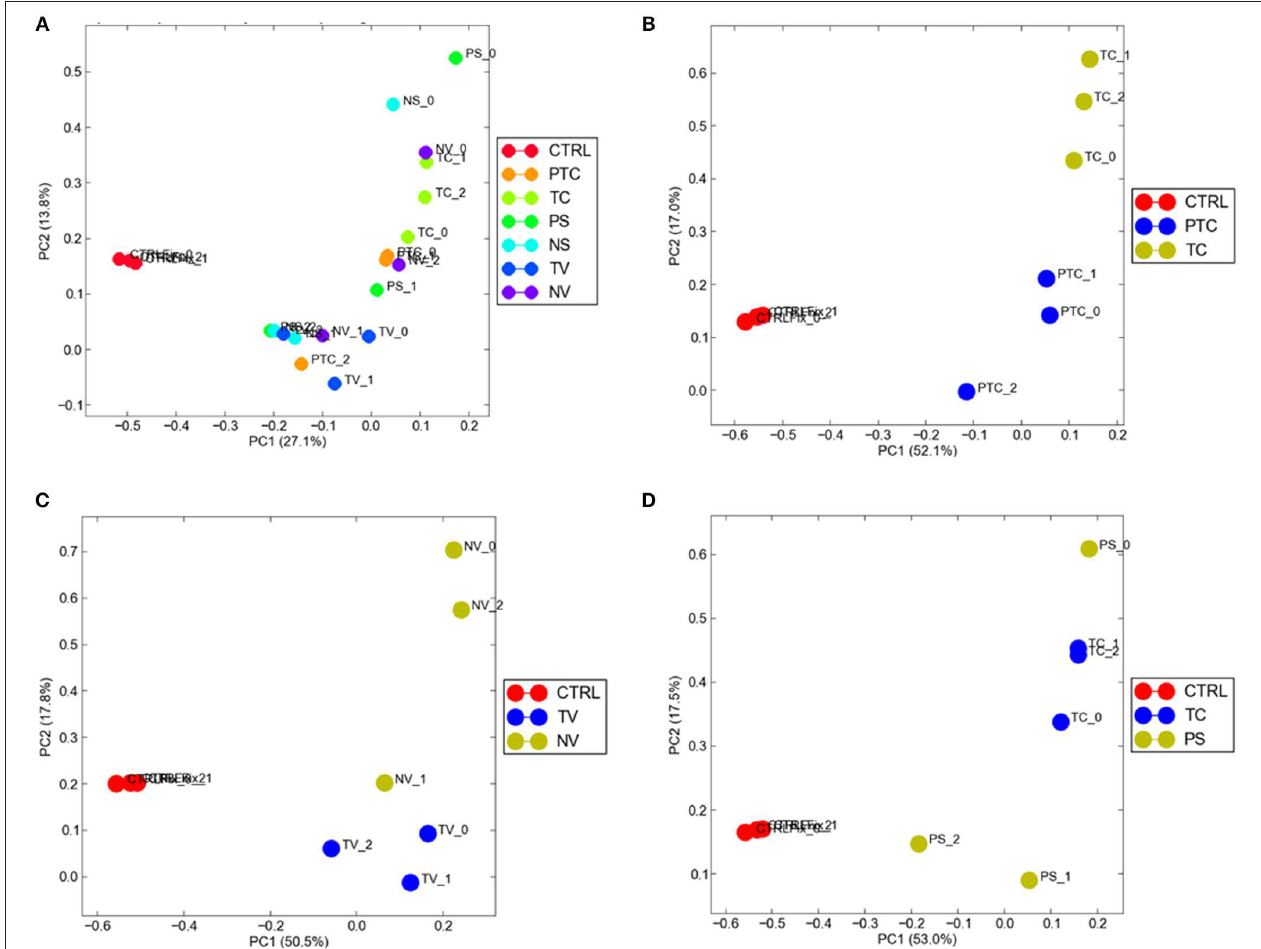
FIGURE 4 | Distribution of normal tissues and cancer subtypes in the principal component space. (A) control tissue and the tumor samples are represented in two different areas of the 2D plots in the first dimension (PC1); gene expression diversity was captured and segregated in three different areas by the second dimension (PC2) when compared TC and PTC (B) , TC and PS (C) , TV and NV (D)